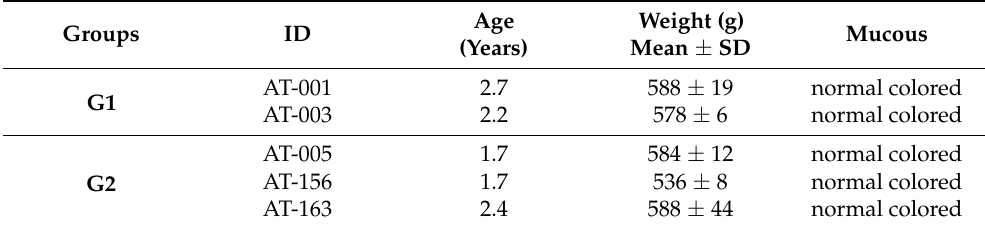
Table 2. Overview of the clinical evaluation of the animals used in the study.